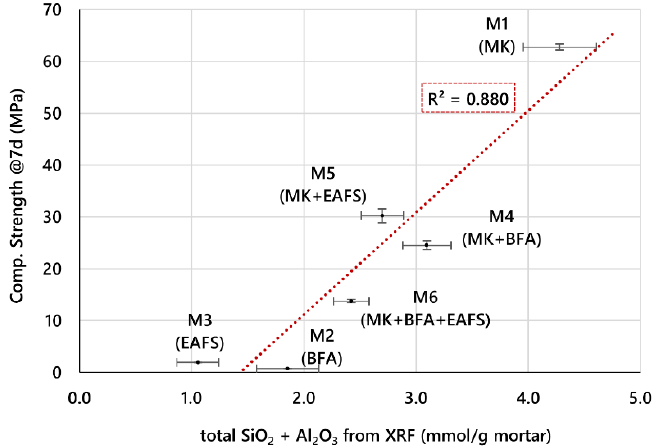
Figure 10. Correlation between CS of GPC mortars and total aluminosilicates based on precursor SiO2 and Al3O2 content as measured by XRF.